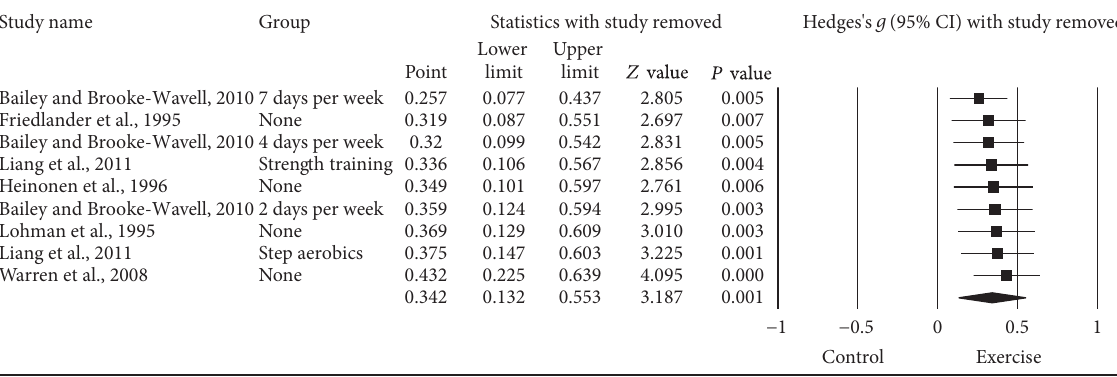
) in FN BMD ) while the 𝑔𝑔 con�dence 𝑔𝑔 %